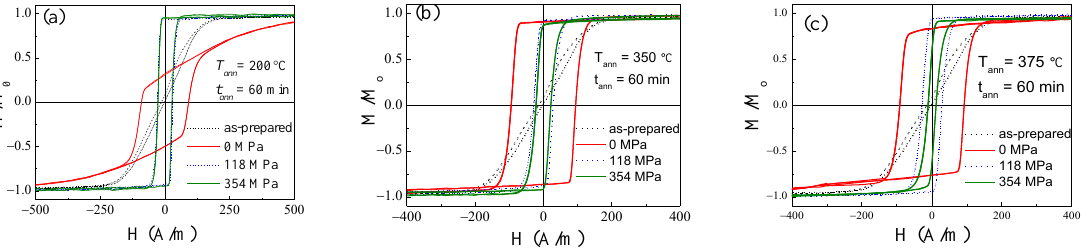
conditions: T ann = 200 °C ( a ), T ann = 350 °C ( b ) and T ann = 375 °C ( c ). (Reproduced with permission from